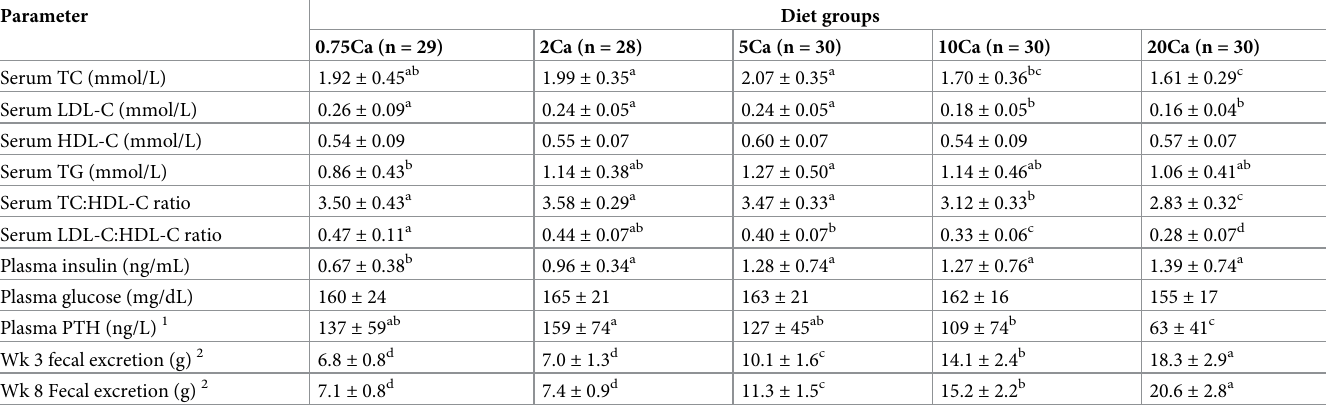
Values are means ± SD. Values in a row without a common superscript letter differ, p < 0.05. 1 n = 25–30. 2 Feces were collect for 7 consecutive days, freeze-dried and